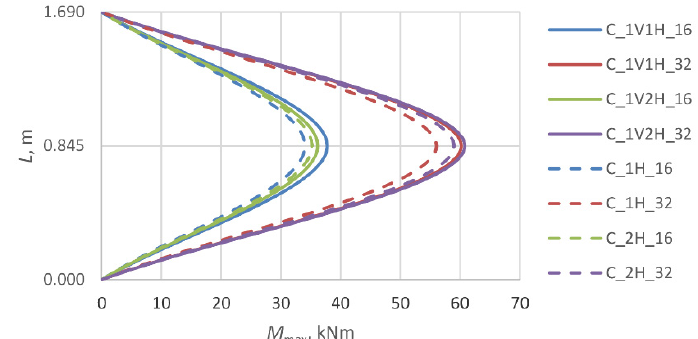
Figure 13. The bending moment of the eccentrically loaded columns.